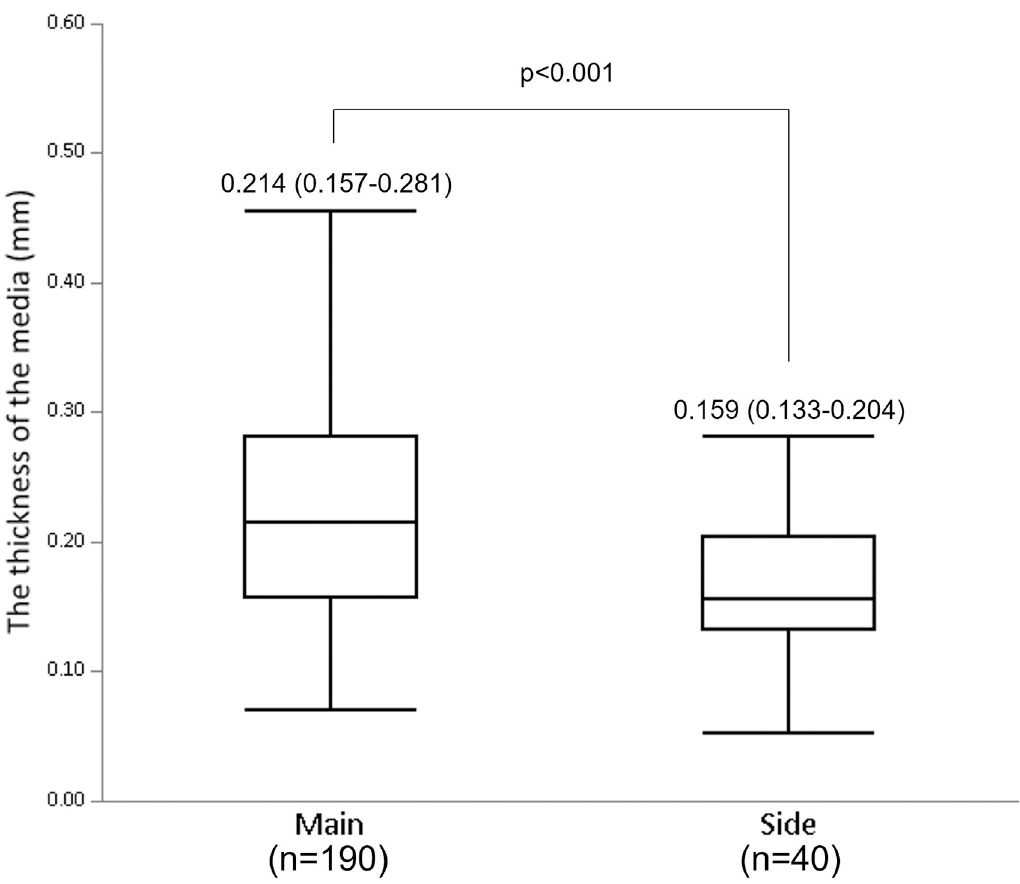
Fig 1. The comparison of the medial thicknesses between main and side branches. The median thickness of the media in the main branches was significantly higher than in the side branches (0.214 mm [0.157–0.281mm] vs 0.159 mm [0.133–0.204 mm], respectively, p < 0.001).